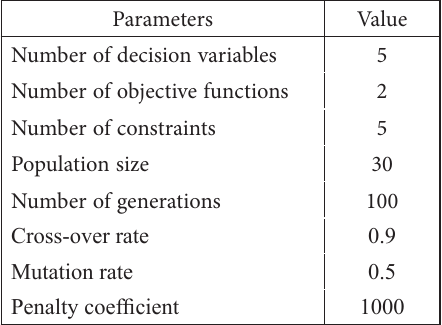
Table 1. Parameters of